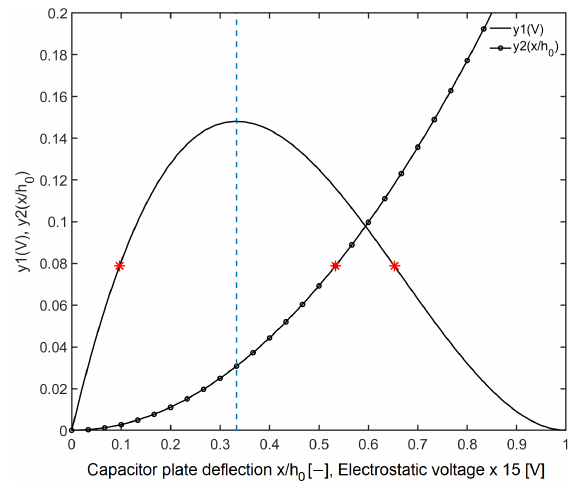
Figure 3. Plot of unitless functions y 1 ( V ) and y 2 ( x / h 0 ) upon their respective variables. The vertical dotted line divides the two stability regions. The asterisk (*) symbol denotes two height-bias points in the stable and unstable